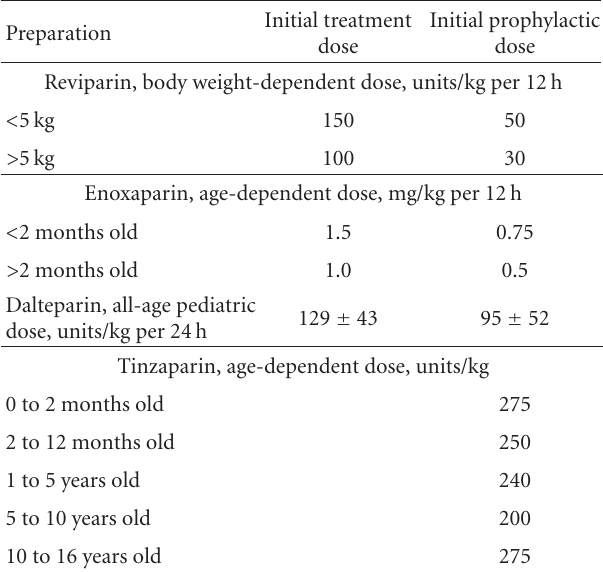
Table 3: Protocol for using LMWH in